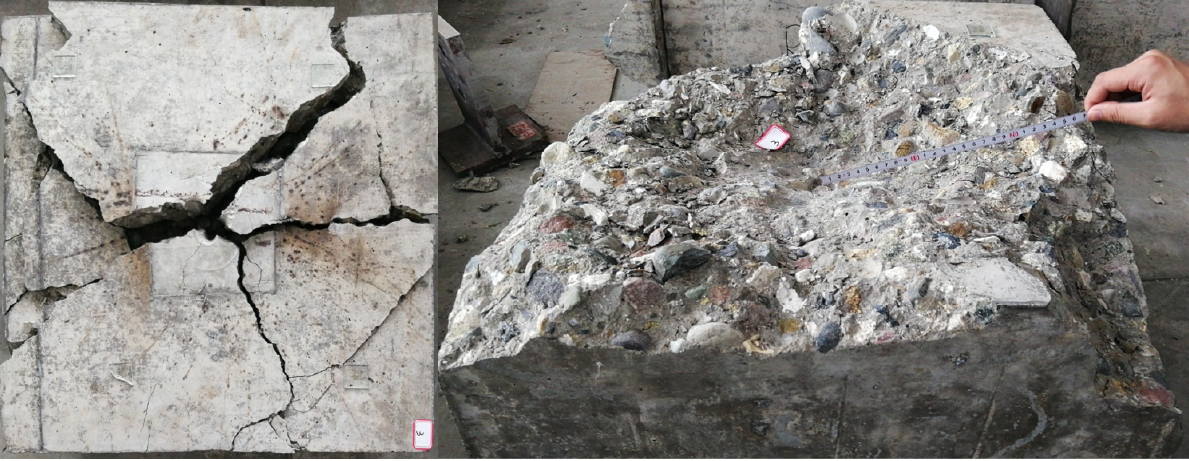
Figure 6. Concrete cone failure mode of NC19-2 specimen.